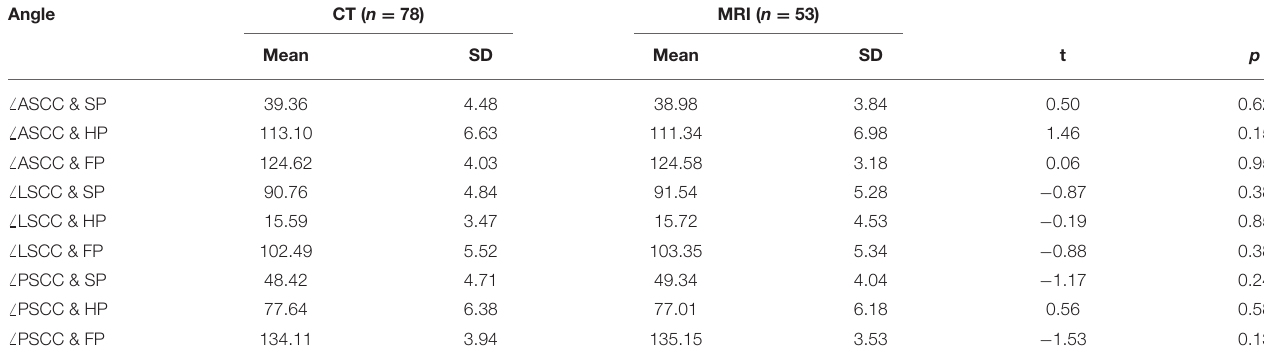
TABLE 3 | Angles (degrees) between the planes of the semicircular canals and the sagittal plane (SP), horizontal plane (HP), and frontal plane (FP).